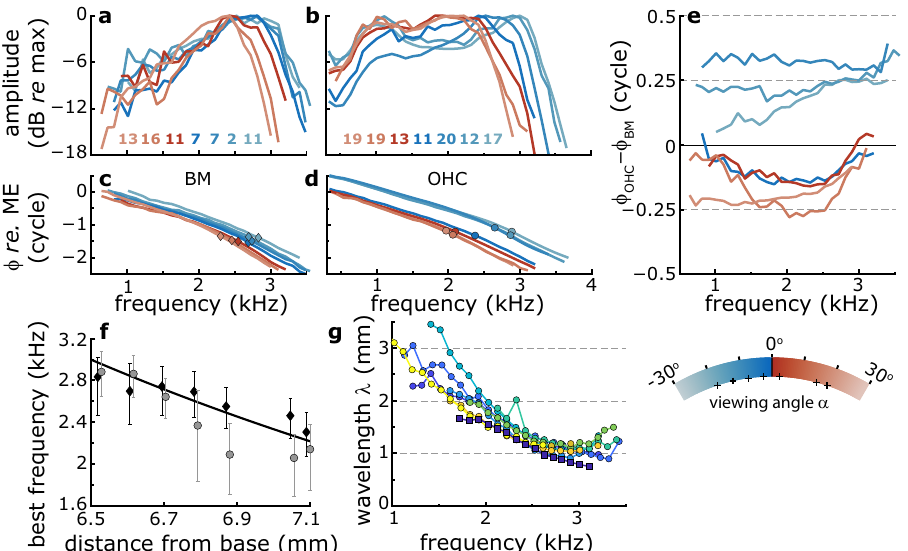
Fig. 2 Vibratory responses along the longitudinal axis of the cochlea. Relative amplitude of ( a ) BM and ( b ) OHC vibratory frequency response curves (FRCs) measured at different longitudinal locations in the gerbil cochlea. Different colors correspond to the color coding for recording location in Fig. 1b. Color-coded amplitudes (dB re. 1 nm) at BF are given in the keys. c , d Corresponding phase data, normalized to the middle-ear (ME) response. Diamonds and circles indicate best frequency (BF). e Phase difference between the responses in the OHC region and on the BM at each longitudinal recording location. f BF for the BM (black diamonds) and the OHC region (gray circles) determined from the FRC amplitude curves in a and b . Error bars give FRC- bandwidth at 1-dB below the BF response. The black line is a fi t of the gerbil place-frequency map 18 to the BM-BFs. This fi t was used to set the values along the abscissa. Stimulus level: 30 dB SPL per frequency component. g Wavelength of the TW. Here, each color represents a separate set of recordings that were obtained from n = 6 animals. We did not observe a dependence of wavelength on stimulus intensity. The square, darkest-blue symbols are from the phase data in c . The lines in a – e are color coded according to viewing angle α (see Fig. 1b ’ ) with the key below e . Small plus-symbols in the key indicate the viewing angles for these recordings.